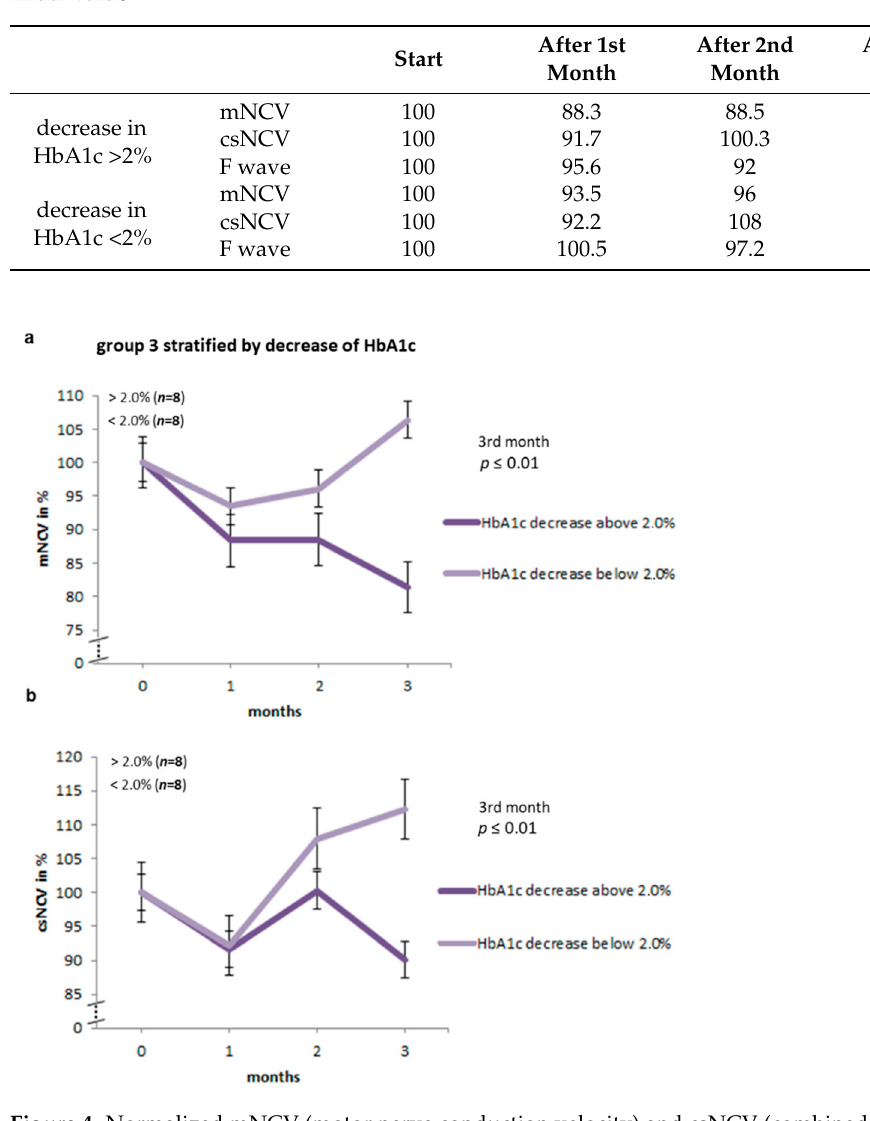
Figure 4. Normalized mNCV (motor nerve conduction velocity) and csNCV (combined sesorimotor nerve conduction velocity) values in animals of group 3 stratified by decrease in HbA1c and depicted for each time point in percent of the initial values. Note that BB/OKL rats with a decrease in HbA1c of more than 2% showed significant slower mNCV ( a ) and scNCV ( b ) after three months as compared to the animals with a decrease of less than 2% (mean values are given in Table 4). Data from n = 8 per group are presented as mean ±